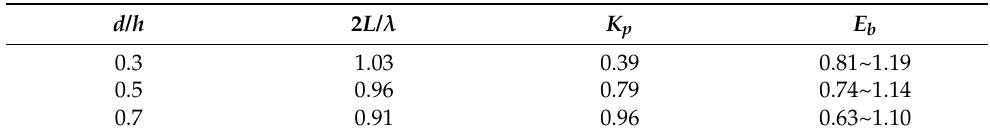
Figure 7. Reflection coefficient versus 2 L / λ under different immerged depths of plates ( N = 3 and L / h = 3.0). Table 2. Characteristics of Bragg reflection under different immerged depths of plates ( N = 3 and L / h =